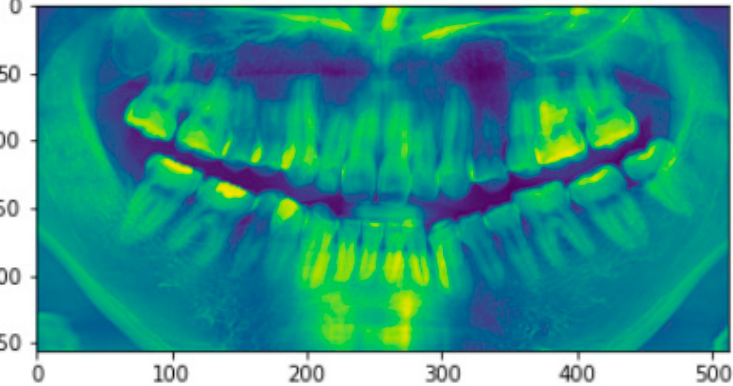
Figure 9. Example of a misclassified image with an error of more than five years; the actual age was in the 20s, but the predicted age was 30.61.